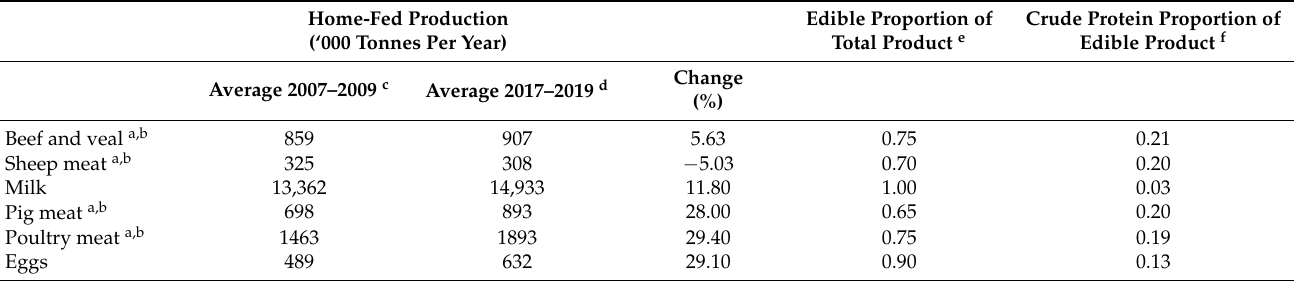
Table 1. Home-fed UK production of livestock products, human-edible and crude protein proportions.